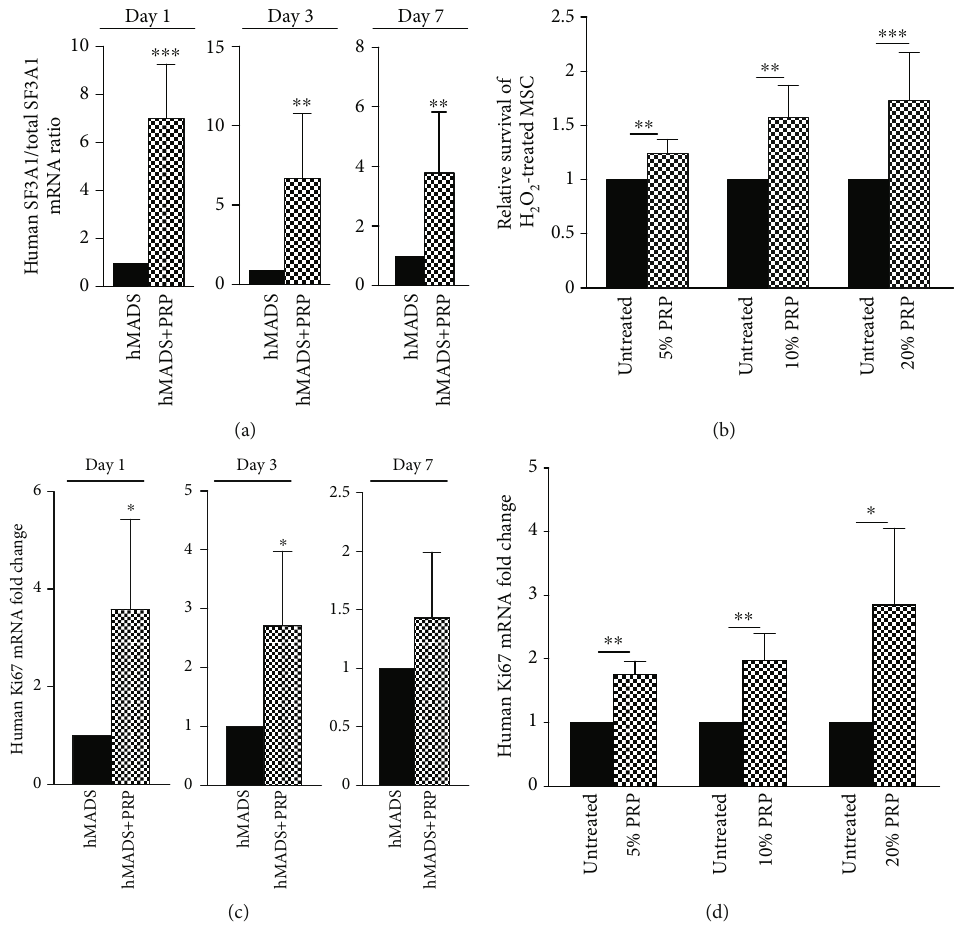
Figure 4: PRP treatment improves the survival and the proliferation of hMADS cells both in vitro and in vivo . (a) Relative survival of hMADS cells engrafted in combination with PRP in mouse wounds by reference to engrafted untreated hMADS cells, assessed by quantitative transcriptional expression of human SF3A1 gene, at day 1, day 3, and day 7. Data represent the mean ± SD of n = 6 mice per group independent experiments. ∗∗ p < 0 : 01 , ∗∗∗ p < 0 : 001 . (b) Relative survival of H O -injured hMADS cells following exposure to 5%, 10%, or 2 2 20% PRP by reference to PRP-untreated H O -injured cells (untreated) assessed by Annexin V/7ADD staining and fl ow cytometry 2 2 analysis. Data represent the mean ± SD of n = 6 independent experiments. ∗∗ p < 0 : 01 , ∗∗∗ p < 0 : 001 , ∗∗∗∗ p < 0 : 0001 . (c) Relative human ki67 transcriptional expression in mouse wounds corresponding to the expression of hMADS cells engrafted in combination with PRP by reference to the expression of hMADS cells engrafted alone, at day 1, day 3, and day 7 postinjury. Results represent the mean ± SD obtained from at least n = 5 mice per group. ∗ p < 0 : 05 . (d) Relative ki67 transcriptional expression of hMADS cells following a 24-hour exposure to 5%, 10%, or 20% PRP by reference to hMADS cells grown in basal medium in the absence of PRP (untreated). Data represent the mean ± SD of n = 6 independent experiments. ∗ p < 0 : 05 , ∗∗ p < 0 : 01